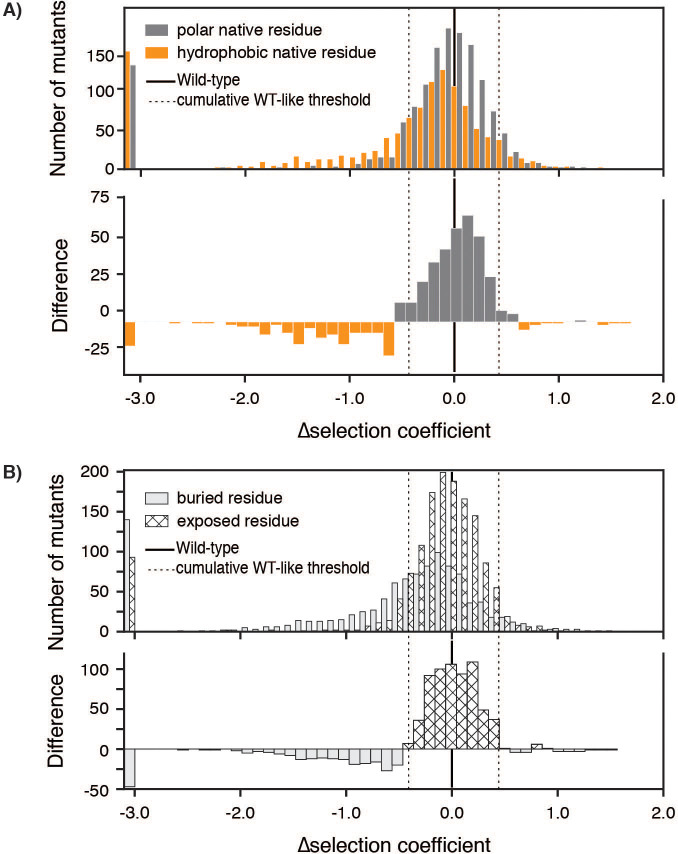
∆selection coefficients.(A) Histogram of ∆selection coefficients (top) with mutants at positions with hydrophobic (AVILMWFY) wild-type amino acid residues in orange and at positions with polar (HKRSTNQDE) wild-type amino acid residues in grey. Selection coefficients for positions with a wild-type P, G, or C residue are not included. The difference of the histograms (bottom) is shown with grey indicating more mutants to positions with a wild-type polar residue and orange indicating more mutants to positions with a wild-type hydrophobic residue. Dotted lines indicate twice the median of standard deviations from Figure 1, Figure 1—figure supplement 3. (B) Histogram of ∆selection coefficients (top) with mutants at buried positions (solid) and at exposed positions (hatched) as listed in Figure 3—source data 1. Selection coefficients for positions that were Intolerant in –Lon selection are not included. The difference of the histograms (bottom) is shown with solid indicating more mutants to buried positions and hatched indicating more mutants to exposed positions.